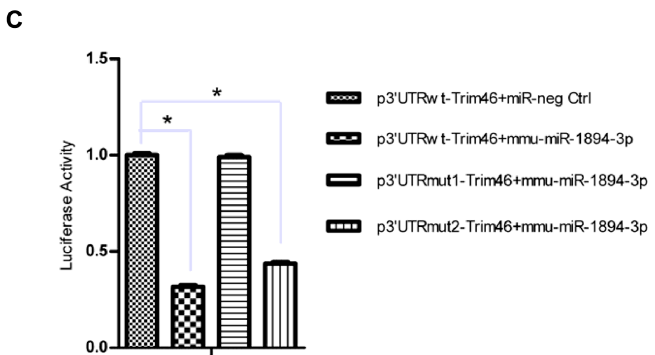
Figure 2. Mmu-miR-1894-3p directly targets Trim46. ( A ) The expression of Trim46 in 4TO7 cell lines was determined by western blot. GAPDH was used for normalization. *** indicates p < 0.001 versus control; ( B ) Two putative binding sites for mmu-miR-1894-3p in the 3 ′ -UTR of Trim46 mRNA. Below are the two mutated binding sites in the 3 ′ -UTR of Trim46 mRNA; ( C ) Dual luciferase reporter assays in 293T cells. * indicates p < 0.05 versus control.